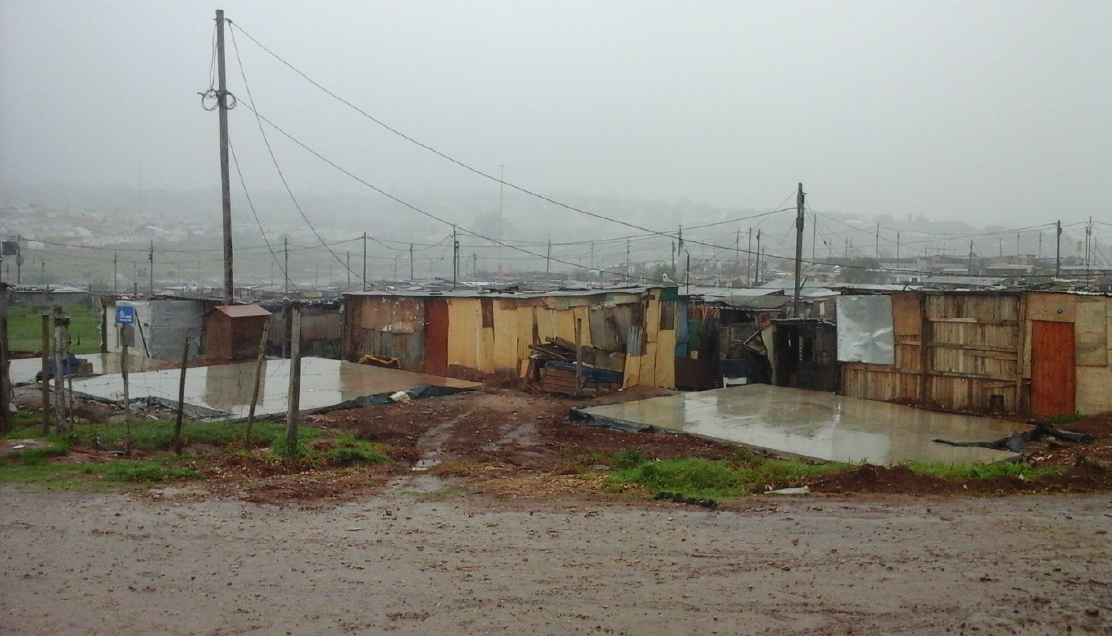
Figure A1. Joe Slovo informal settlement in 2015, Eastern Cape, South Africa.